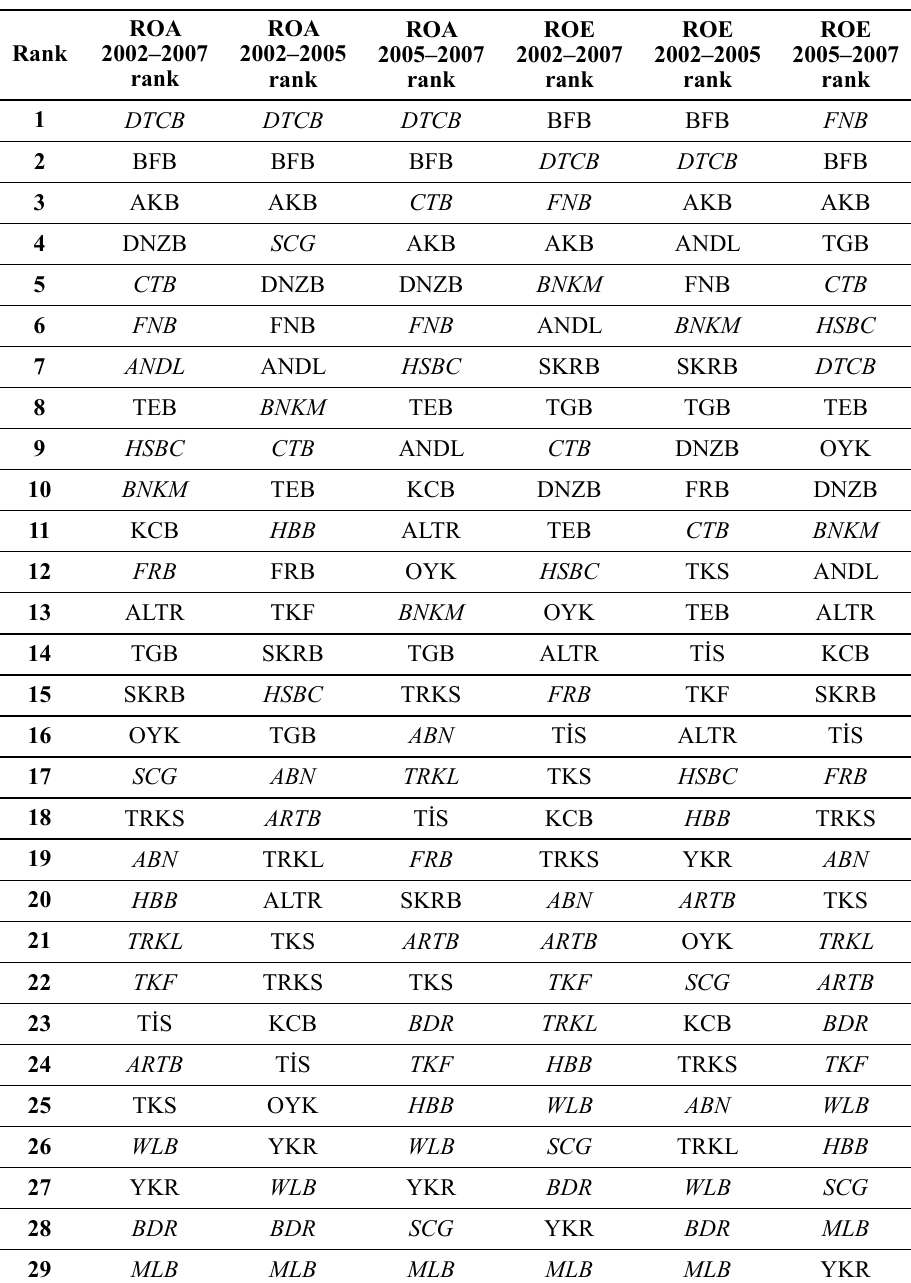
Table A.8. Profitability Ranks of the Banks Excluding State